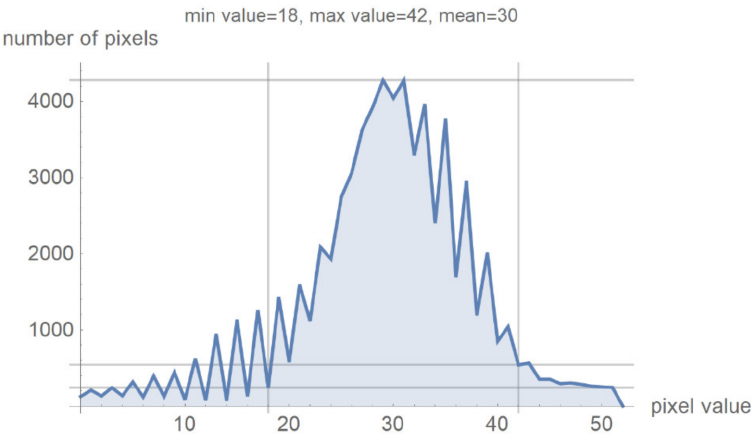
Figure 7. Image histogram for an arbitrarily selected range of up to 24 successive pixel values.